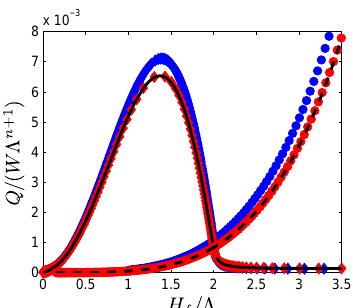
Figure 6. Comparison of the solution of the boundary layer problem with (cid:48) = 0 (black lines, solid for the CD model, dashed for FL) and solutions of the steady-state problem Eq. (6), solved with the param- eter values given in the caption of Fig. 3. Plotted is scaled, normal- ized ice flux against scaled, normalized ice thickness for ε = 10 − 2 (blue symbols) and ε = 10 − 4 (red symbols). Diamonds show solu- tions for the CD model, and circles show solutions for the calving